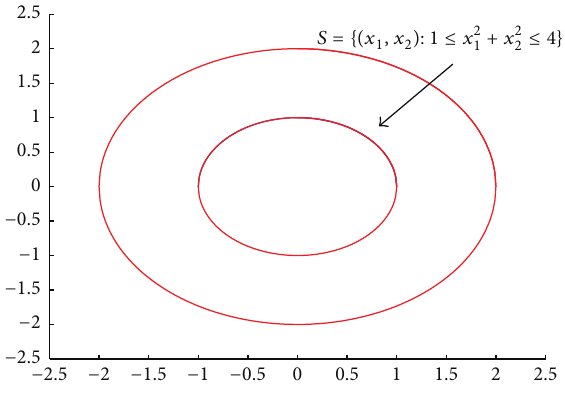
Figure 2: The nonconvex set 𝑆 in Example